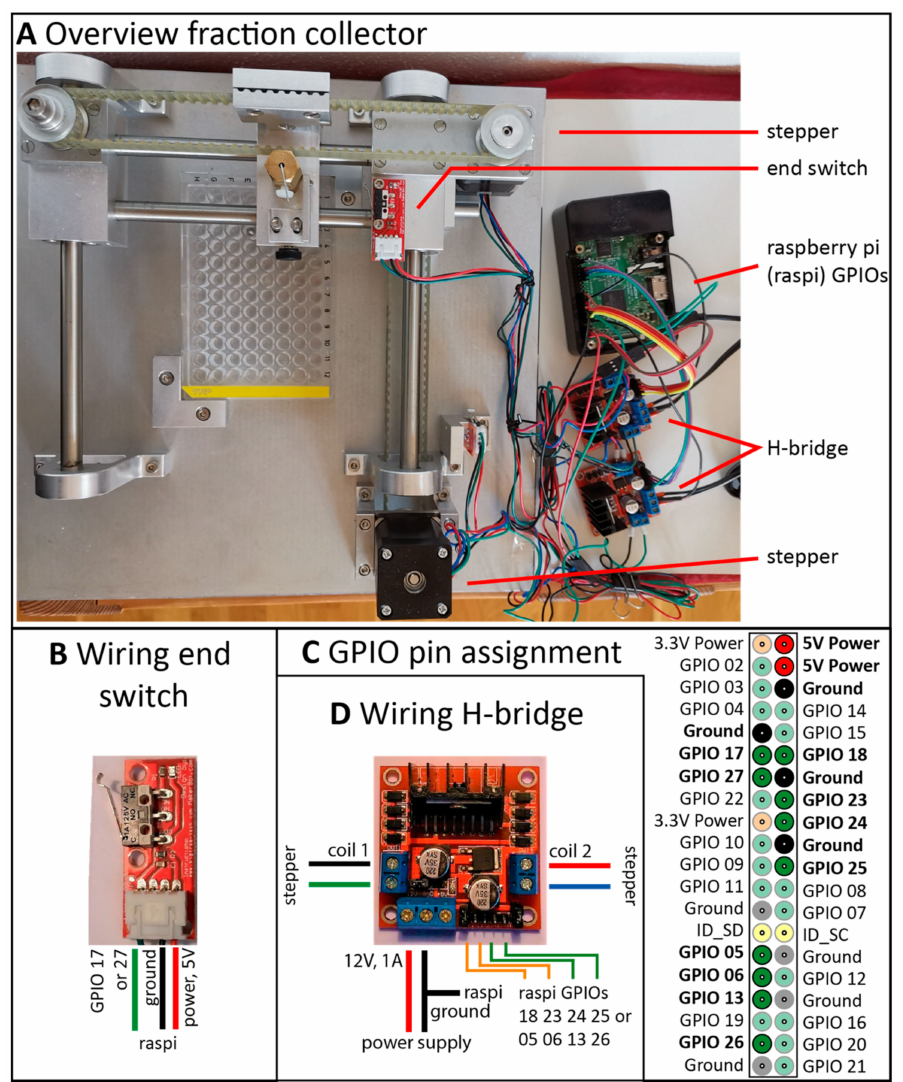
Figure 3. Overview over the fraction collector. ( A ) Overview fraction collector. ( B ) Wiring of the end switches. The end switches are supplied with 5V power from the pins of the raspberry pi, and the signal is sent from the switches to GPIO 17 or 27 (green wire). ( C ) GPIO pin assignment. Schematics of the GPIO pins of the raspberry pi. Saturated colors and bold script indicate utilized pins. ( D ) Wiring of the H-bridge. Each H-bridge controls one stepper motor. Power is supplied by a 12 V, 1 A switching power supply and routed to each stepper motor by four output wires (coil one: black and green wires; coil two: red and blue wires). Power distribution is controlled by the GPIO pins. GPIOs 18 and 23 or 05 and 06 (orange wires) control the direction of coil one, while GPIOs 24 and 25 or 13 and 26 (light green wires) control the direction of coil